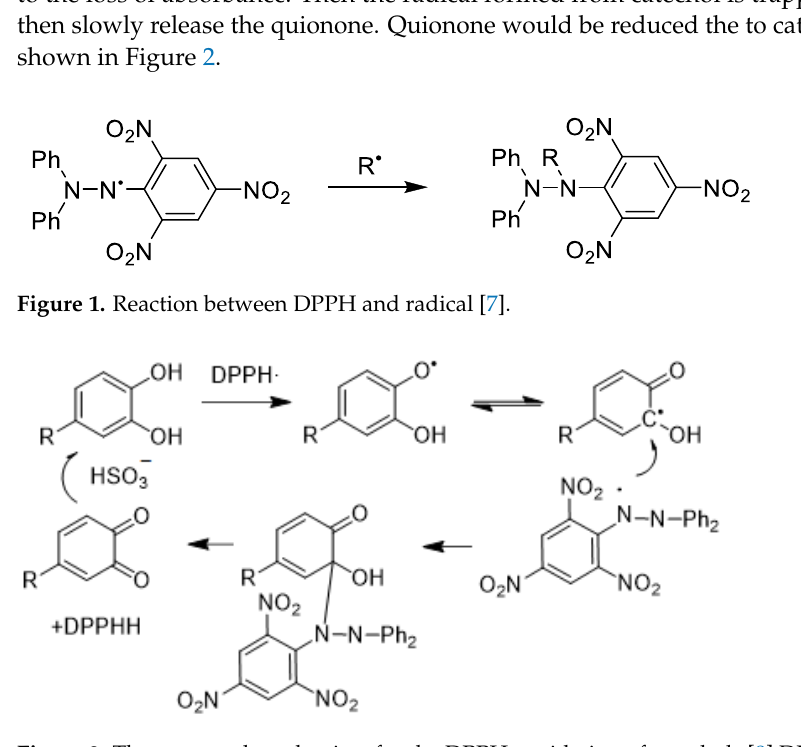
Figure 2. The proposed mechanism for the DPPH• oxidation of catechols [8] DPPH . High-performance liquid chromatography (HPLC) assay and Folin-Ciocalteu (FC)